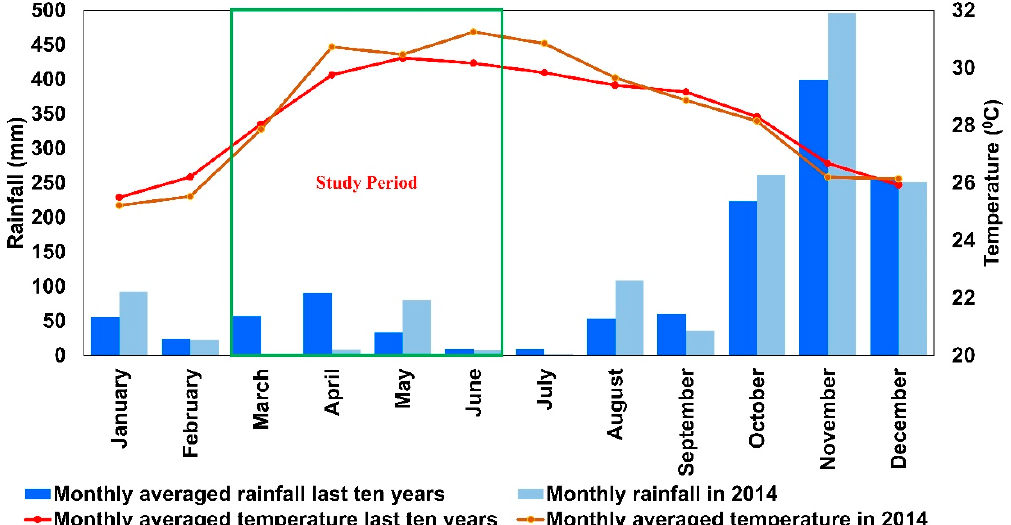
Figure 1. Mean monthly rainfall and temperature for last ten years, and monthly rainfall and mean temperature of Jaffna in 2014 (Data source: Meteorological Department of Sri Lanka, 2015).